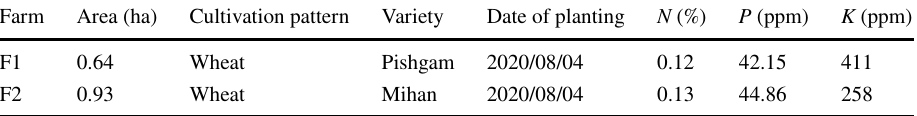
Table 2 Soil survey and harvest